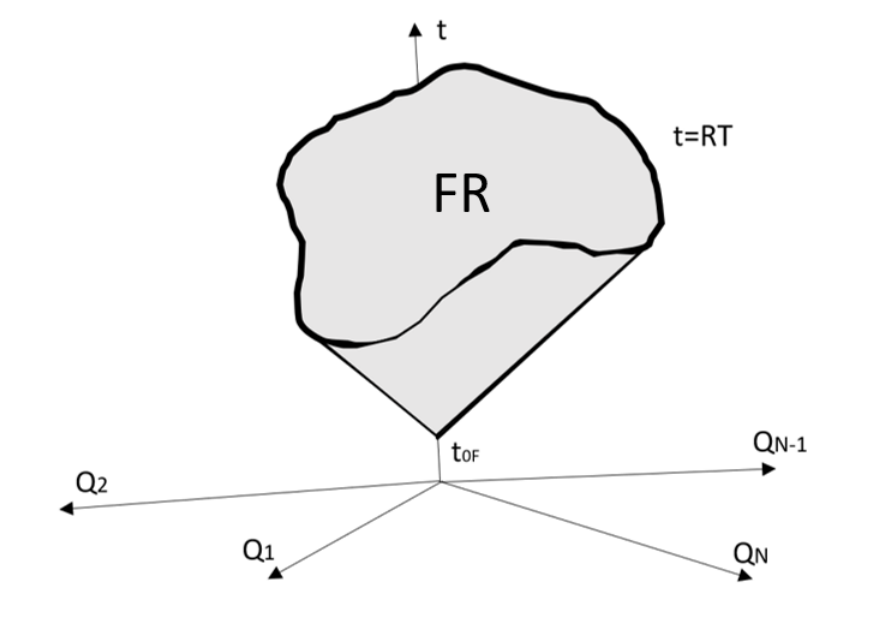
Figure 1. Multidimensional formulation of FR.